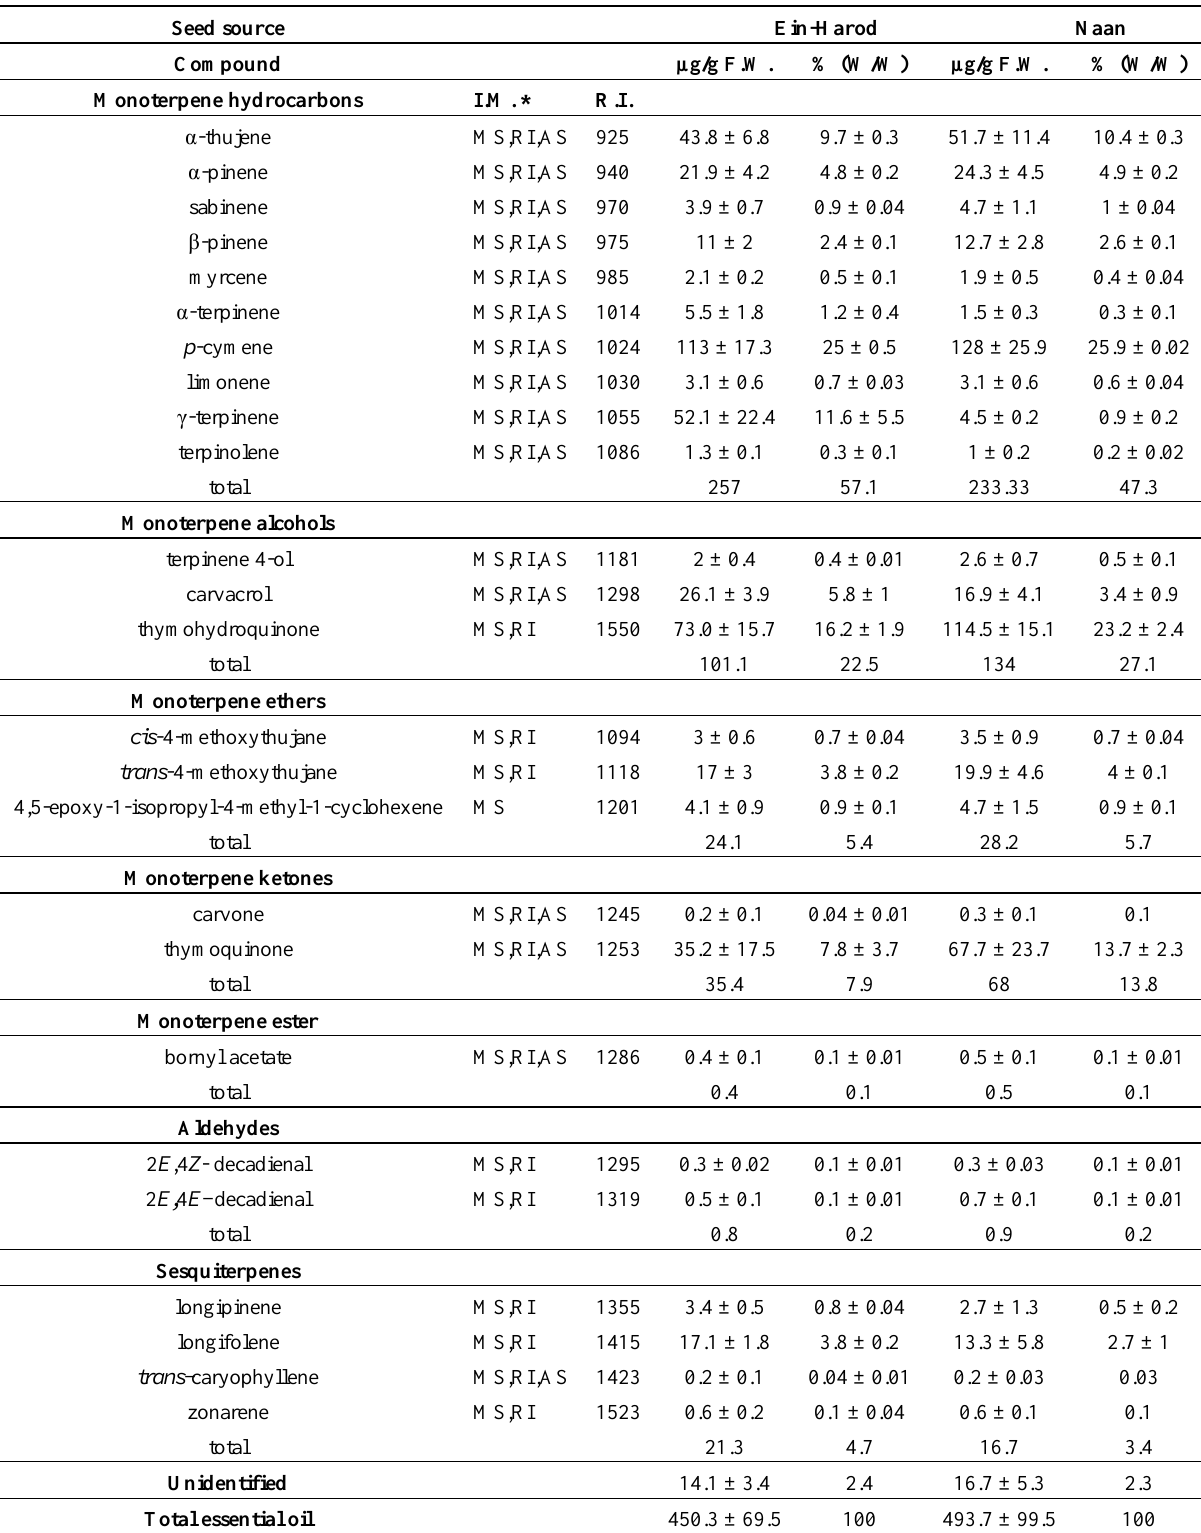
Table 1. Volatiles of mature Nigella sativa seeds from two seed sources. The volatiles were extracted with MTBE and identified by GC-MS as described in Materials and Methods. Means are average of 3 replicates ±